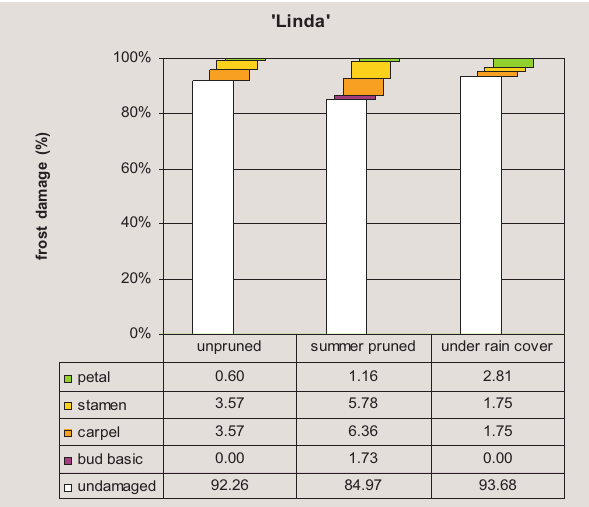
Figure 5. Frost damage in buds of the variety ’Linda’ observed on trees in